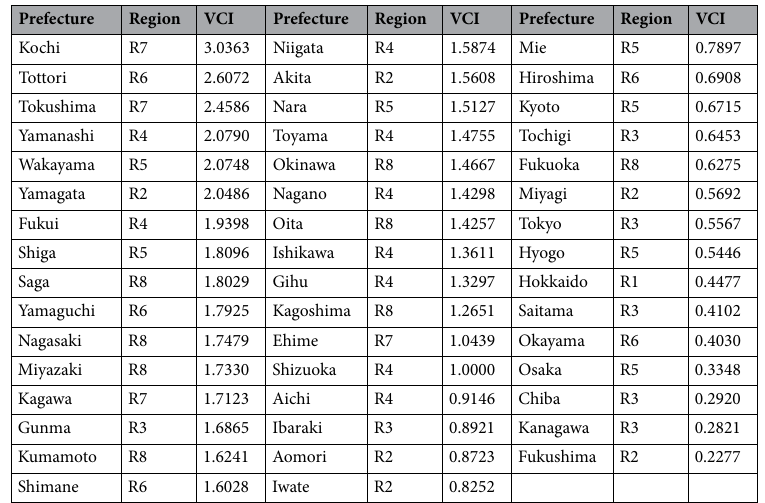
Table 1. List of the 47 prefectures with the VCI sorted in descending order. The higher the VCI, the higher the levels of societal concern towards vaccines or vaccination. The Region column indicates the larger geographic region where each prefecture is located. There are eight regions in Japan: Hokkaido (R1), Tohoku (R2), Kanto (R3), Chubu (R4), Kansai (R5), Chugoku (R6), Shikoku (R7), and Kyushu and Okinawa (R8).